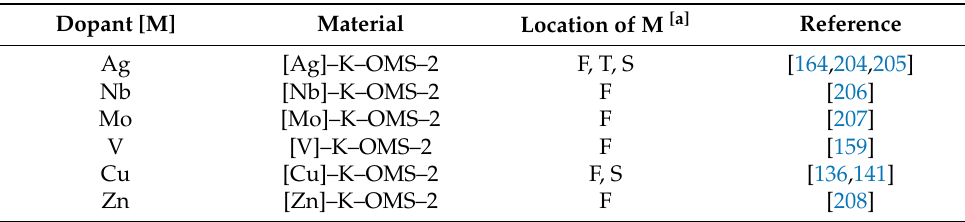
Table 7. List of recently doped K–OMS–2 catalysts applied in CO oxidation. Dopant [M]